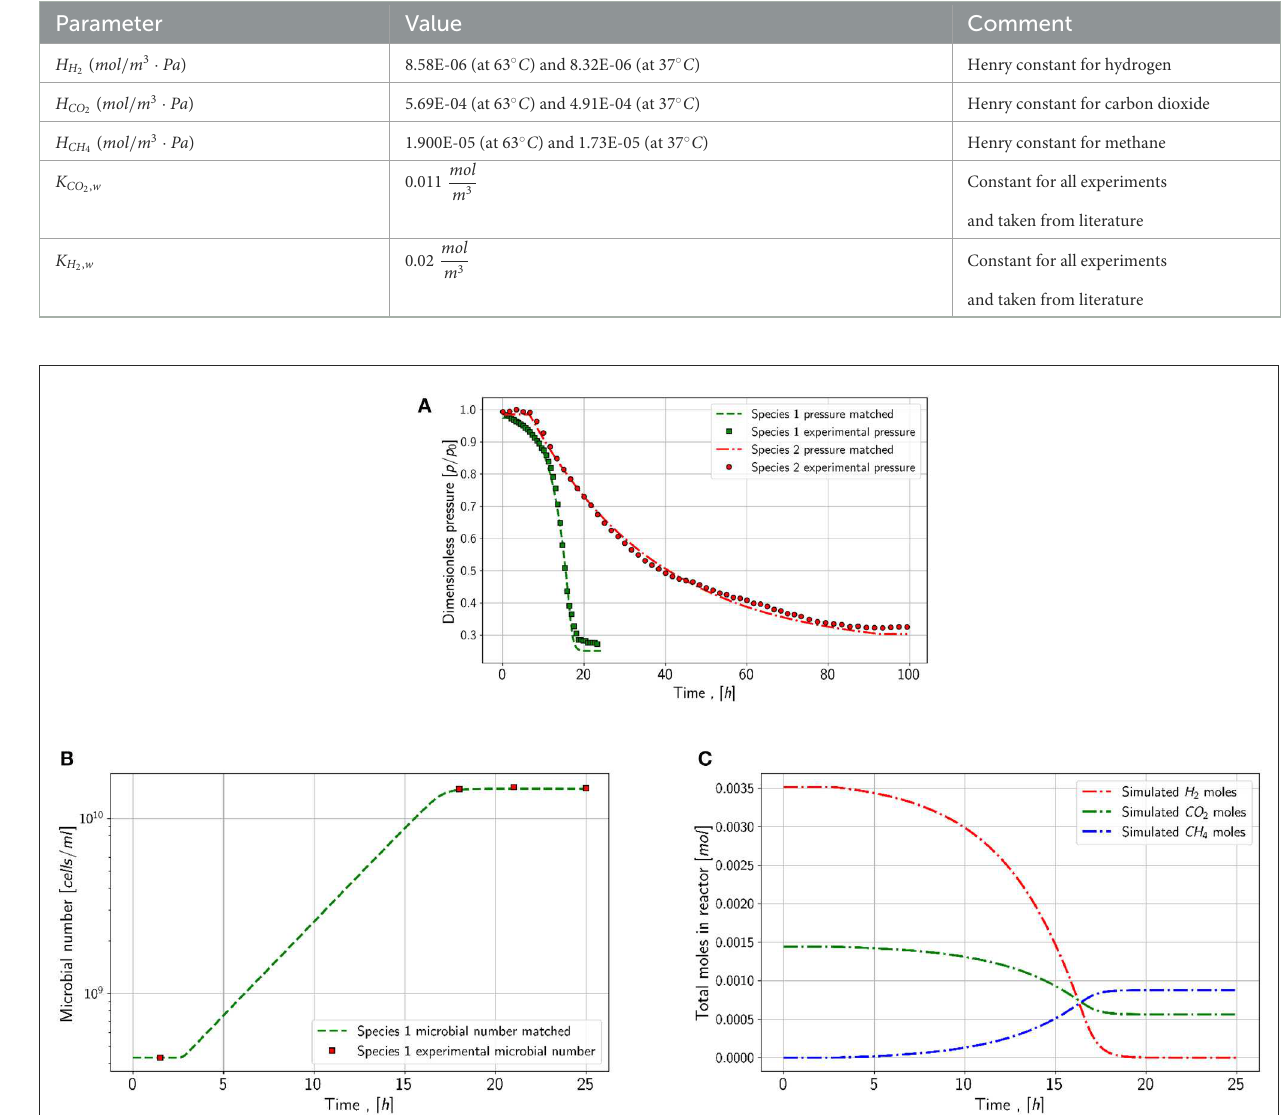
FIGURE5 Simulation results for series 1. (A) Pressure match for species 1 (green) and species 2 (red) (B) Match microbial concentration in the reactor for species 1 (C) Simulated moles in the reactor for species 1 during the matched experiment.